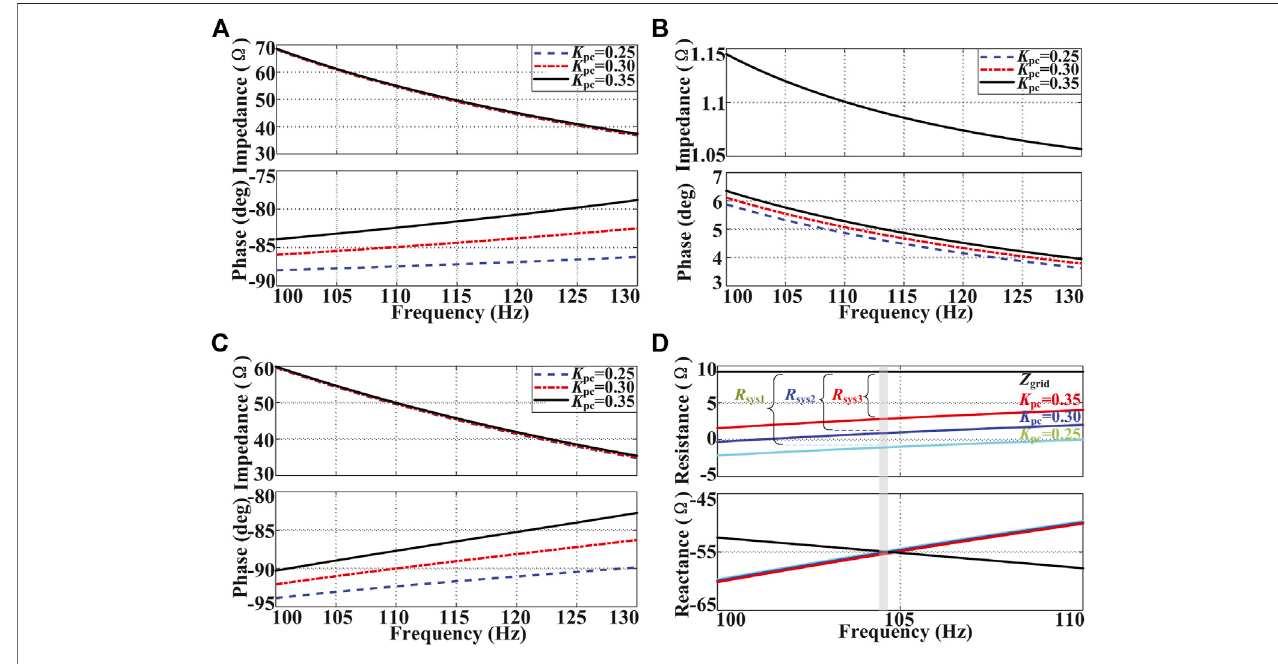
FIGURE 7 | Impact of K pc on the impedance-frequency curves. (A) Z vsc , nopll ( s ) ; (B) Z pll ( s ) ; (C) Z vsc ( s ) ; and (D) Z vsc ( s ) and Z grid ( s ) .